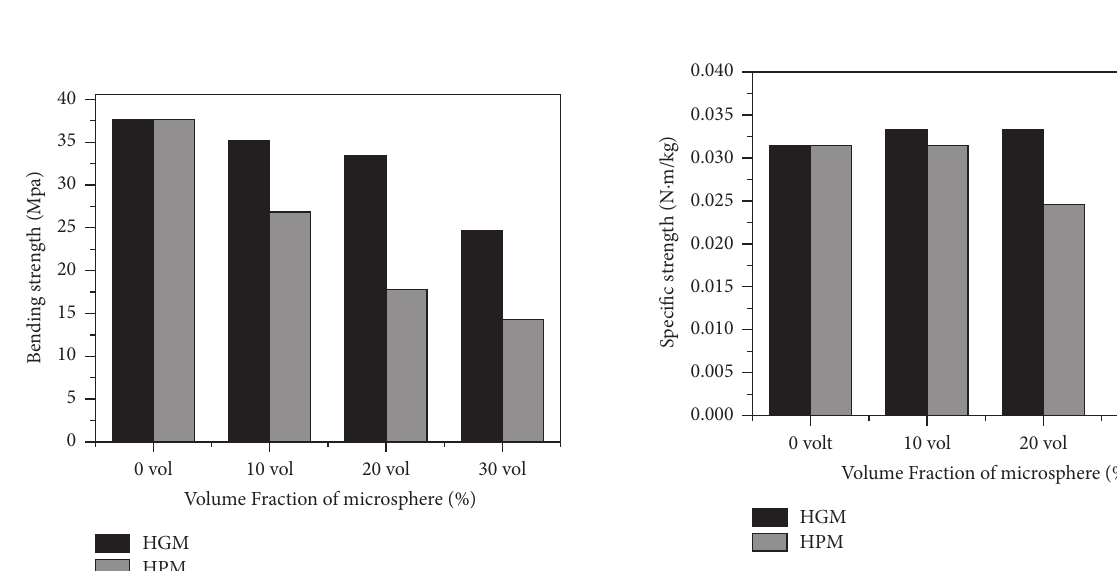
Figure 9: Bending strength of phenolic syntactic foams.